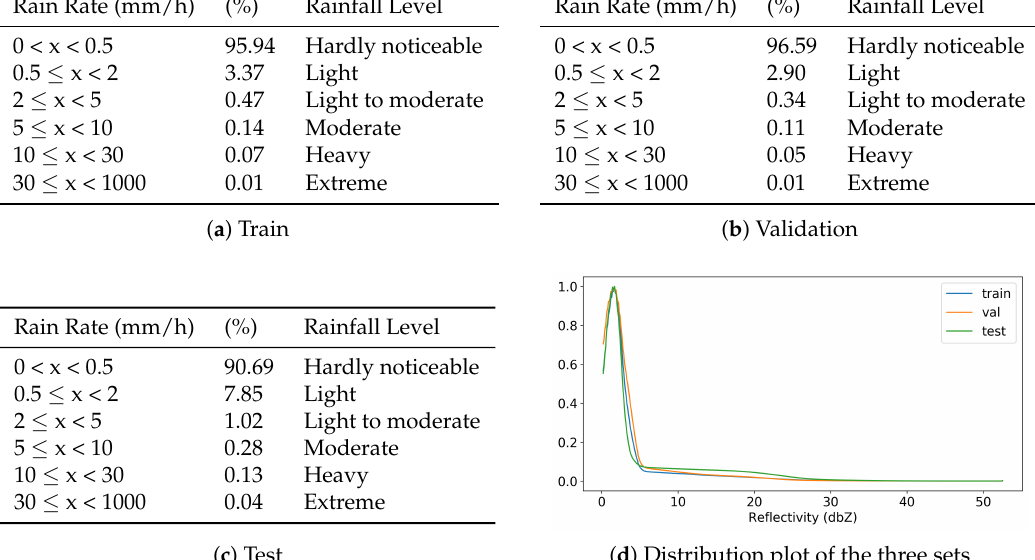
( c ) Test ( d ) Distribution plot of the three sets Figure 6. Distribution of the rainrate values for the three sets used for train ( a ), validation ( b ) and test ( c ). ( d ) shows the plot of the distribution of the reflectivity values in the three sets. Zero values are removed since they dominate the distribution.